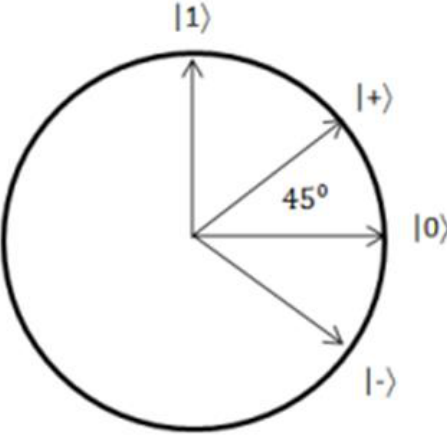
Figure 11. |+ ⟩ and | − ⟩ quantum state. Figure 11. |+ 〉 and | − 〉 quantum state.